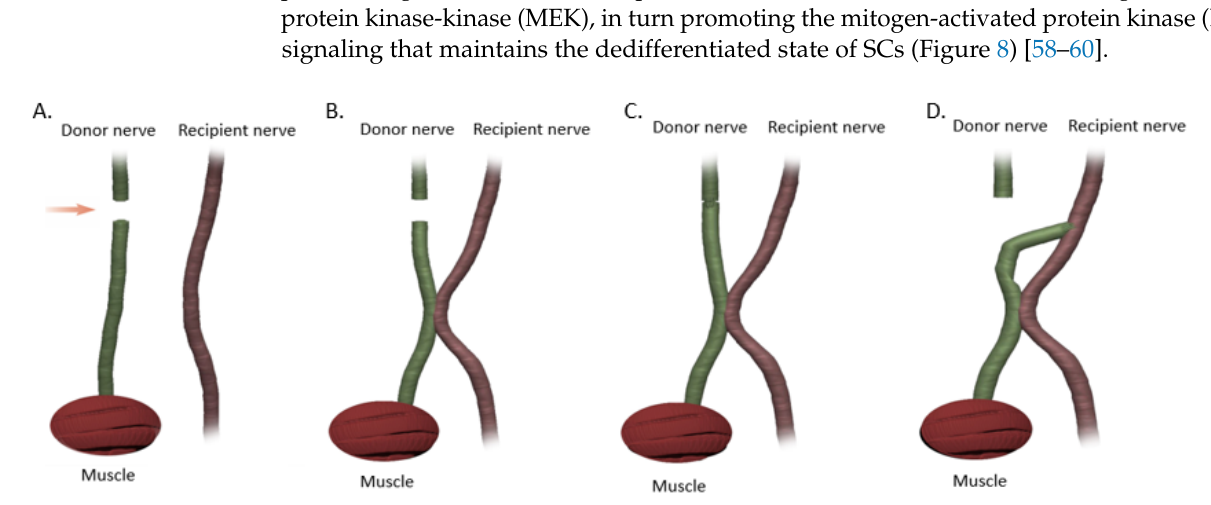
Figure 7. End-to-end (ETE) nerve repair technique demonstrating the coaptation of the injured nerve distal to the site of injury to an intact donor nerve (DN) through an epineural window. ( A ) Nerve injury. ( B ) Injury with downstream STS repair. ( C ) Injury with ETE repair at the site of injury and downstream STS repair. ( D ) Injury with ETS repair at the site of injury and downstream STS repair. Arrow points to the level of injury.